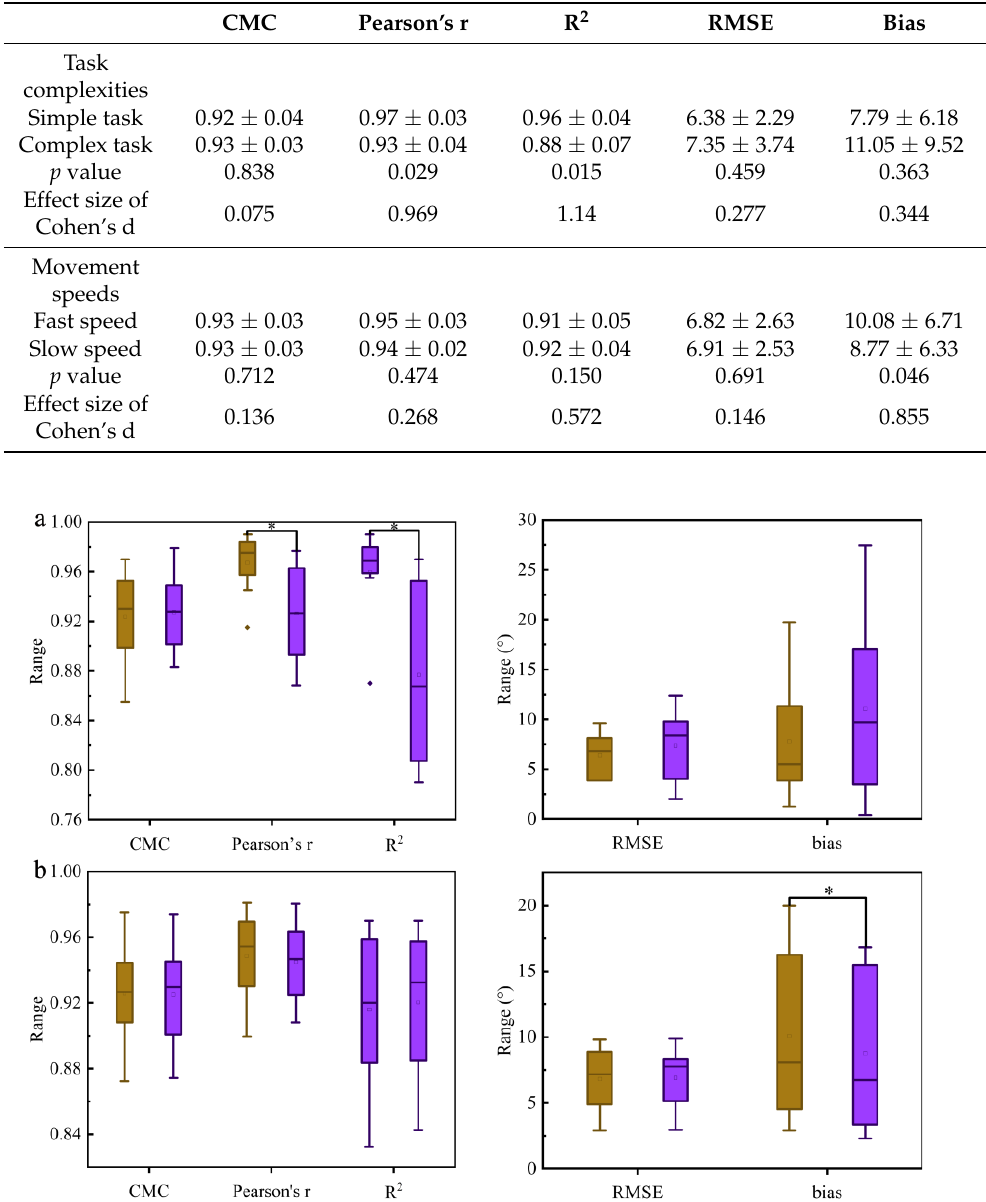
Table 3. Paired t -test for validity metrics between task complexities and between movement speeds.